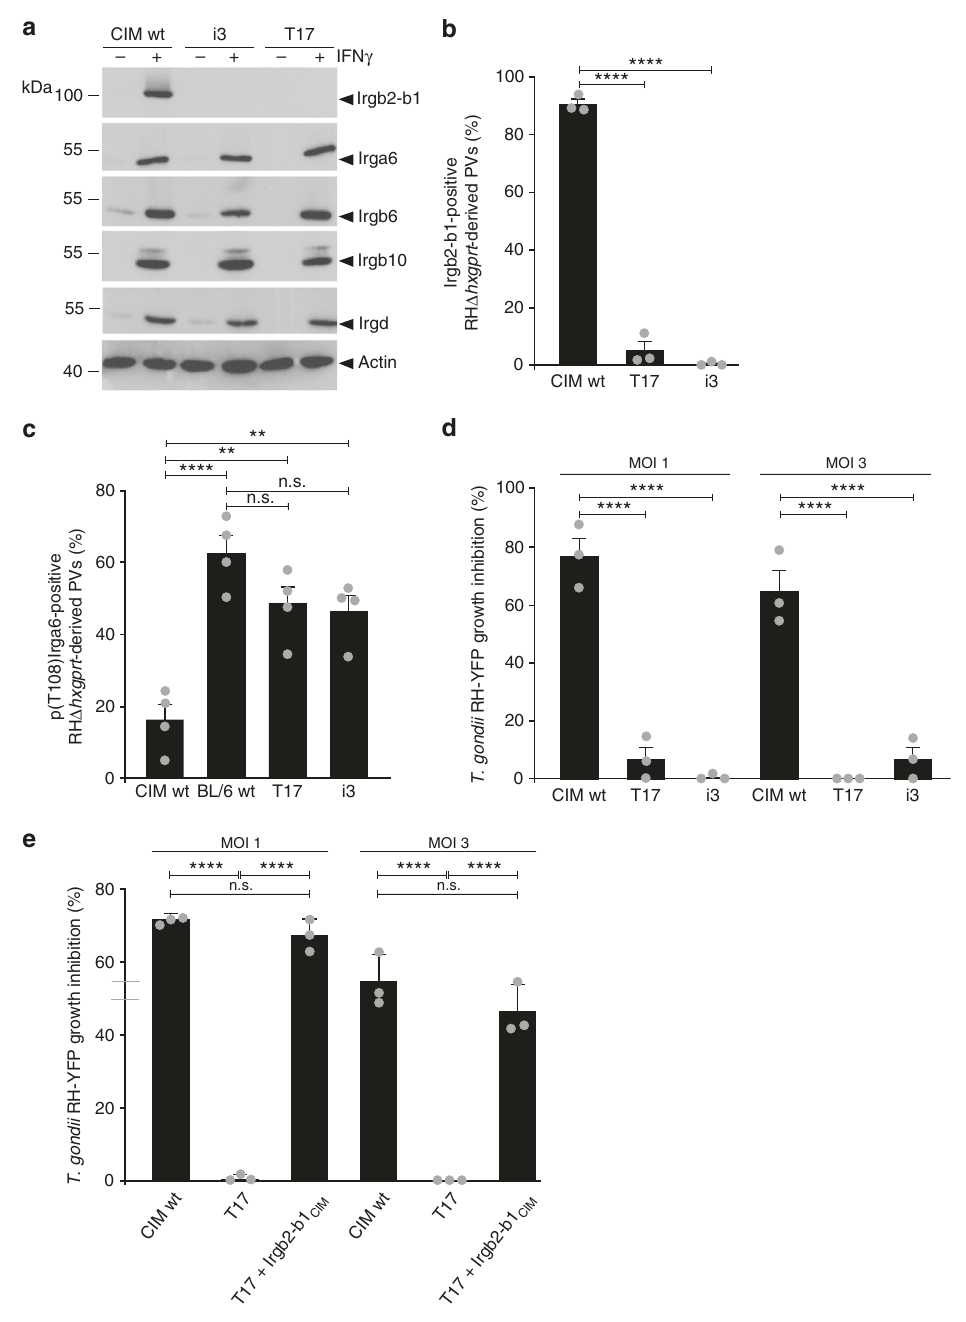
Fig. 1 Irgb2-b1 CIM is largely responsible for resistance against virulent T. gondii strains. a Western blot of detergent lysates from CIM wild-type (wt) and Irgb2-b1 CIM knockout (ko) diaphragm-derived cells (DDCs) (T17 and i3) stimulated for 24 h with 200 U ml − 1 interferon- γ (IFN γ ). The signal representing Irgb2-b1 CIM in wt cells is lost in both ko cell lines (upper panel). Expression levels of all other Immunity-Related GTPases (IRG) proteins are unchanged in ko cell lines compared with wt cells (middle panels). Actin serves as loading control (lower panel). b , c Frequency of vacuoles positive for Irgb2-b1 CIM ( b ) or Irga6 CIM phosphorylated at T108 p(T108)Irga6 CIM ) ( c ) detected by immuno fl uorescence with anti-p(T108)Irga6 CIM or anti-Irgb2-b1 CIM antibodies in IFN γ - induced (200 U ml − 1 ) wt CIM and BL/6 or Irgb2-b1 CIM ko CIM DDCs infected for 2 h with RH Δ hxgprt . Error bars indicate the mean and standard error of the mean (SEM) of three ( b ) or four ( c ) independent experiments (about 100 vacuoles were counted per experiment). One-way analysis of